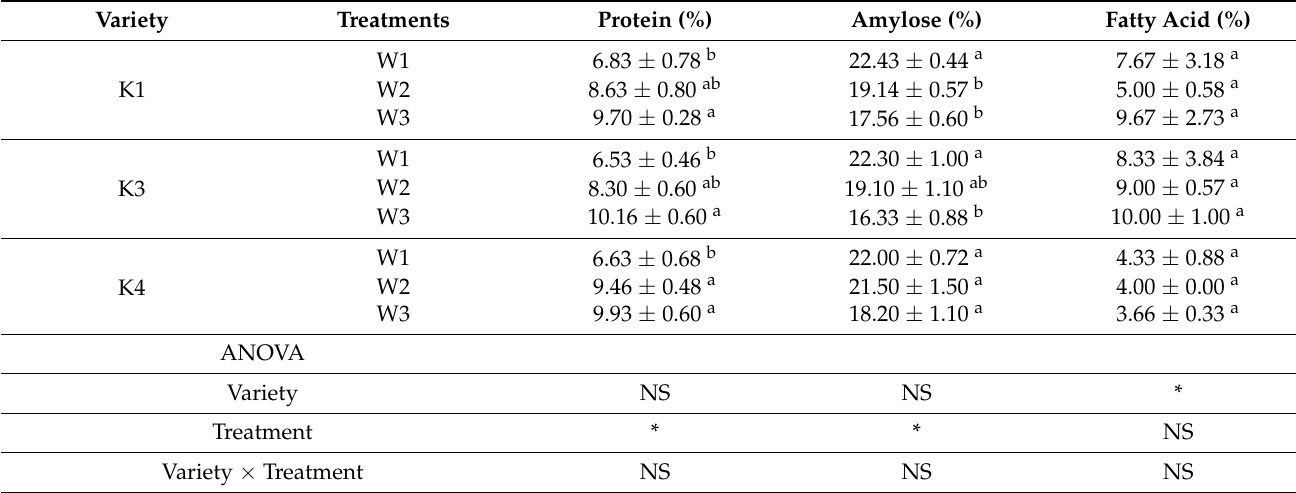
Table 2. Quality parameters of rice grain in response to irrigation interval.